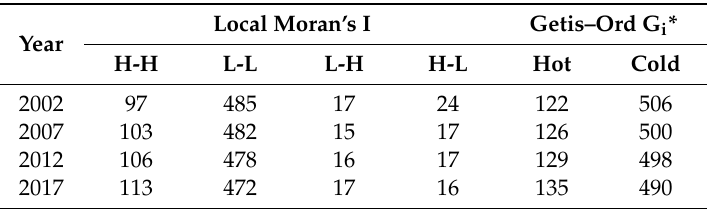
Table 2. Clustering statistics of local Moran’s I and Getis–Ord G i * statistics for population density of sub-districts (number of